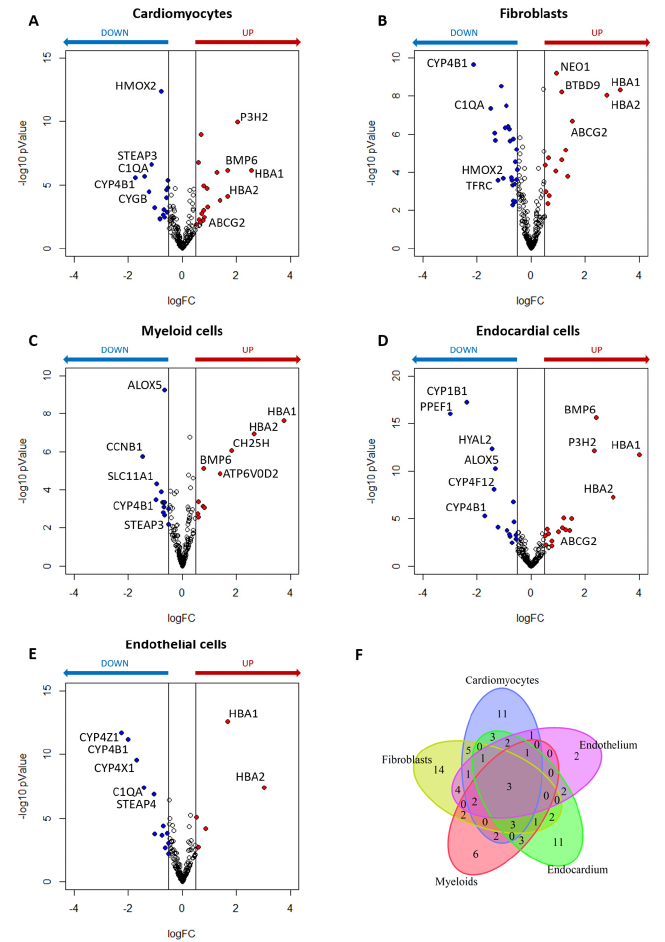
Figure 2. Differentially expressed iron-linked genes analysis for specific cell types in dilated cardi- omyopathy (DCM) patients in comparison to the donors (NF). ( A ) Volcano plot for visualization of differential expressed genes (DEGs) in cardiomyocytes. ( B ) Volcano plot for visualization of DEGs in fibroblasts. ( C ) Volcano plot for visualization of DEGs in myeloid cells. ( D ) Volcano plot for vis- ualization of DEGs in endocardial cells. ( E ) Volcano plot for visualization of DEGs in endothelial cells. ( F ) Venn diagram exhibited the overlapping of the DEGs among the five cell types. Red and blue dots denote significantly up-regulated (adjusted p Value < 0.05 and log(FC) ≥ 0.5) and down- regulated (adjusted p Value < 0.05 and log(FC) ≤ –0.5) genes in DCM, respectively. The empty dots represent the unchanged genes.